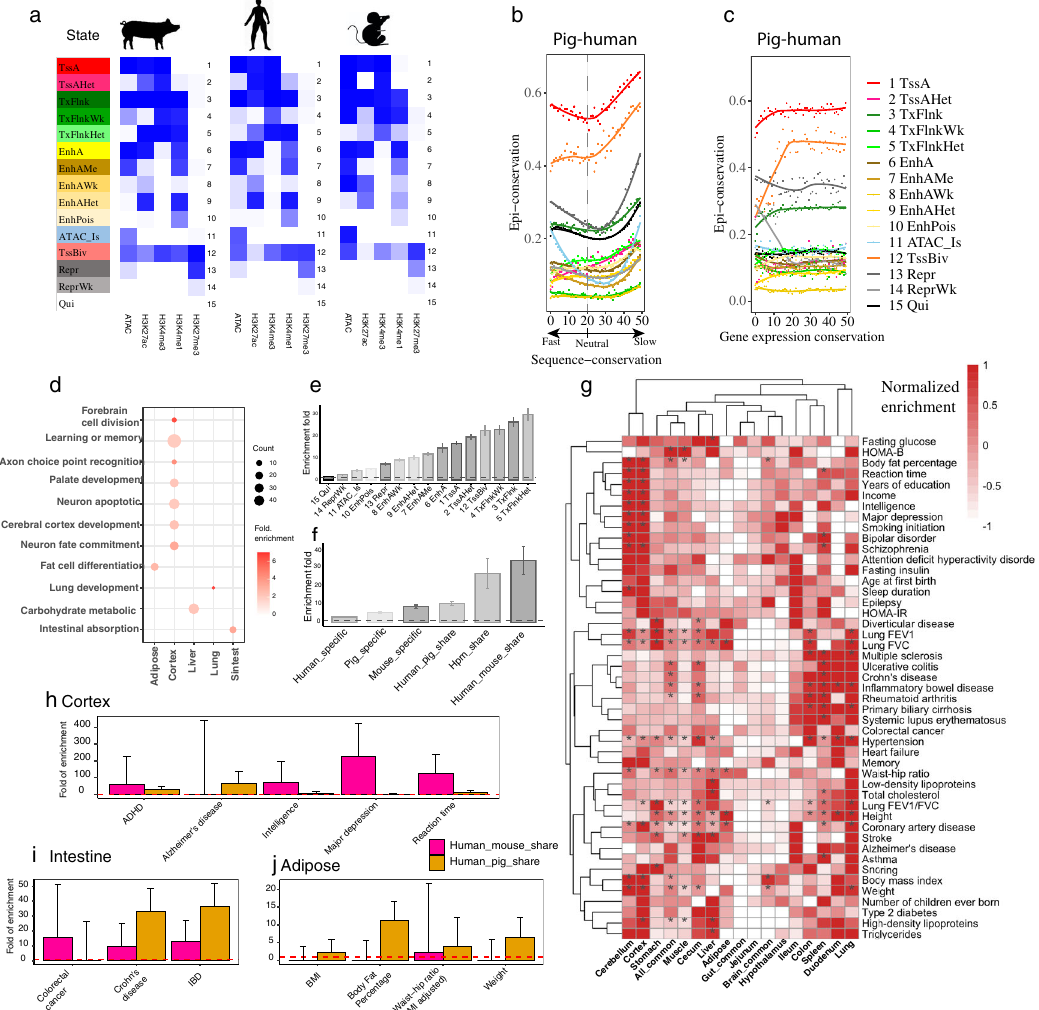
Fig. 6 Interspecies conservation of chromatin states. a 15 chromatin states predicated in three species. The colors from white to deep blue indicate emission probabilities, ranging from 0 to 1. b Relation between sequence conservation and epigenomic conservation across six tissues. Fifty genomic regions were ordered from the fastest changing (0th), neutral (20th), and slowest changing (49th) in terms of sequence conservation (Supplementary Fig. 16d). Epigenome conservation (see Methods section) for each chromatin state within each region was calculated between pigs and humans and plotted. c Relation between expression conservation and epigenomic conservation across six tissues. Expression conservation was based on expression of 14,302 orthologous genes among the three species. Regions were ordered from the biggest difference in expression (0th), to the smallest difference (49th). d GO enrichment was based on genes proximal to (±2 kb) human-speci fi c TssA with extreme sequence conservation (49th). Count refers to the number of genes. e Human GWAS (47 traits) signal enrichment in 15 different chromatin states across six tissues. Enrichment was the proportion of heritability divided by the proportion of SNPs in each chromatin state. Values greater than the dashed line (set at 1) indicate signi fi cant enrichment. Error bars represent standard error around the estimates of enrichment. Dashed lines and error bars are similarly formatted in sub- fi gures ( f , h – j ). f Human GWAS (47 traits) enrichment in six groups of species-speci fi c or shared EnhA across six tissues. (hpm_share stands for human-pig-mouse shared). g GWAS enrichment of pig tissue-speci fi c enhancer (EnhA) in humans. “ * ” indicates FDR < 0.05. h – j Different GWAS enrichments between human-pig and human-mouse shared strong enhancers (EnhA) in brain cortex (1799 vs. 61 enhancers), small intestine (5311 vs. 2430 enhancers), and adipose (2014 vs. 1638 enhancers), respectively. Data in Figs. e – j are available at https://doi.org/10.6084/m9. fi gshare.16531197.v1. (TMM) and transcript per million (TPM) normalization were performed using presented by plotCorrelation. The signal of marks along with protein-coding genes EdgeR (v3.32.0) and StringTie2 (v.1.3.3), respectively 64 . For ChIP-seq, after the were generated by deepTools 68 (computeMatrix scale-regions function) with fi ltering, duplicates were marked and removed using Picard (v.2.18.7). Regions of parameters -a 2500 -b 2500. The Z -score was used to normalize bigWig of fi ve signal enrichment ( “ peaks ” ) were called by MACS2 65 (v.2.1.1). Various quality marks given input fi les. metrics (e.g., Jensen-Shannon divergence (JSD), Supplementary Data 1) were cal- culated following the method described by Kern et al. 29 . RRBS data were processed using Bismark 66 (v.0.22.1) with parameters set in the RRBS pipeline (https:// Annotation of chromatin states . ChromHMM 69 (v.1.20) was used to train the github.com/zhypan/Functional-Annotation-of-Pig). Hi-C contacts were called chromatin state prediction model by integrating ChIP-seq (H3K4me3, H3K4me1, using the Juicer pipeline 67 with default parameters. H3K27ac, H3K27me3, and input control) and ATAC-seq data from two biological The global correlations among assays, tissues, and biological replicates were replicates of 14 tissues. The same tissue of two biological replicates were collectively performed by deepTools 68 (v.3.5.0). Brie fl y, the Z -score normalized read signals of considered as one tissue epigenome. The 15-state model was chosen, as it presented all samples within 1kb windows were calculated by multiBigwigSummary and were maximum number of states with distinct epigenetic mark combinations. We